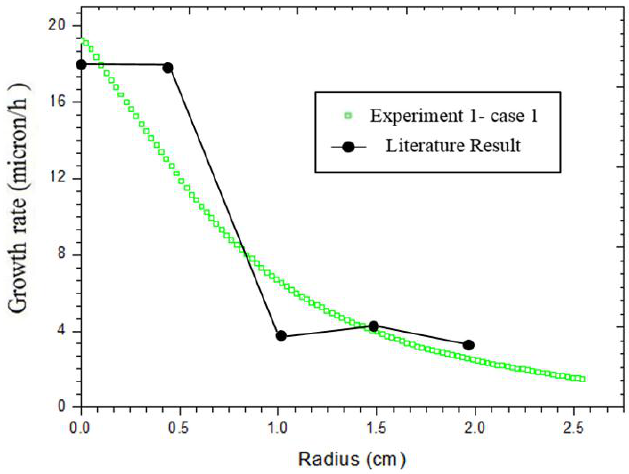
Figure 15. 2D Experiment 1, Case1 result vs. literature results [10].